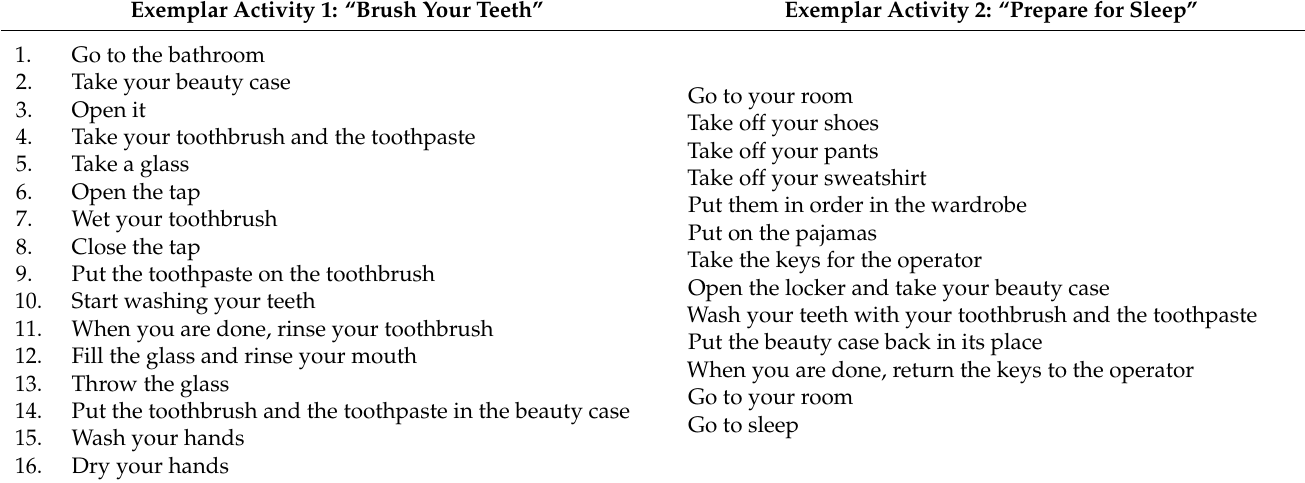
Table 2. List of the steps for two of the activities